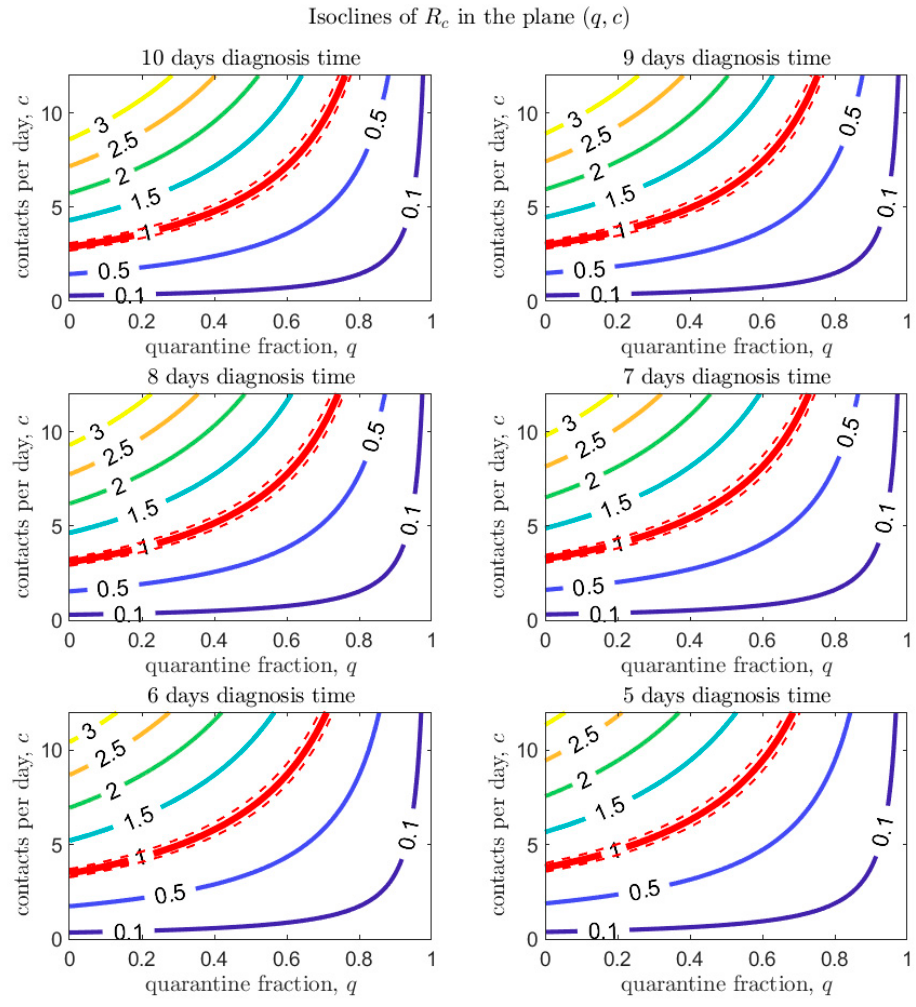
Figure 10. Values of R c in the plane ( q , c ) for di ff erent values of the time for diagnosis (1/ δ I ). The red line corresponds to R c = 1 (with dashed lines showing confidence intervals).